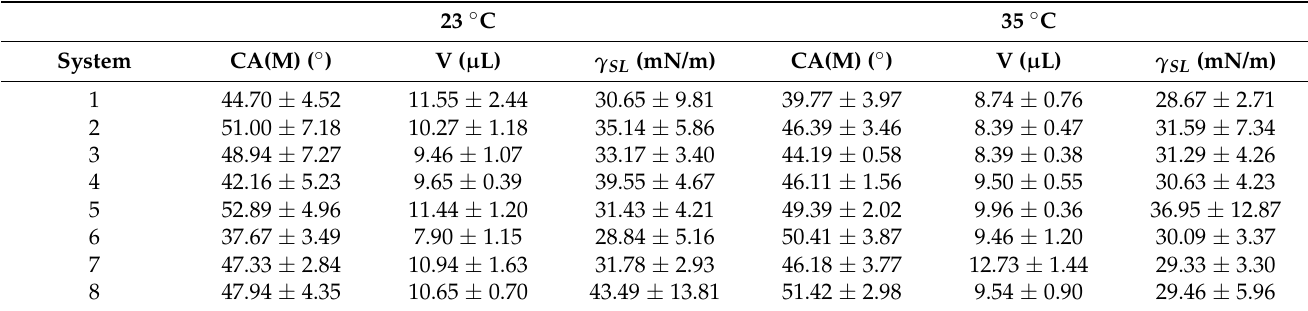
Table 4. Synthesis of experimental data resulting from CA ( ◦ ) evaluation for the polymer systems, analyzed at 23 ◦ C and 35 ◦ C. 23 ◦ C 35 ◦ C System